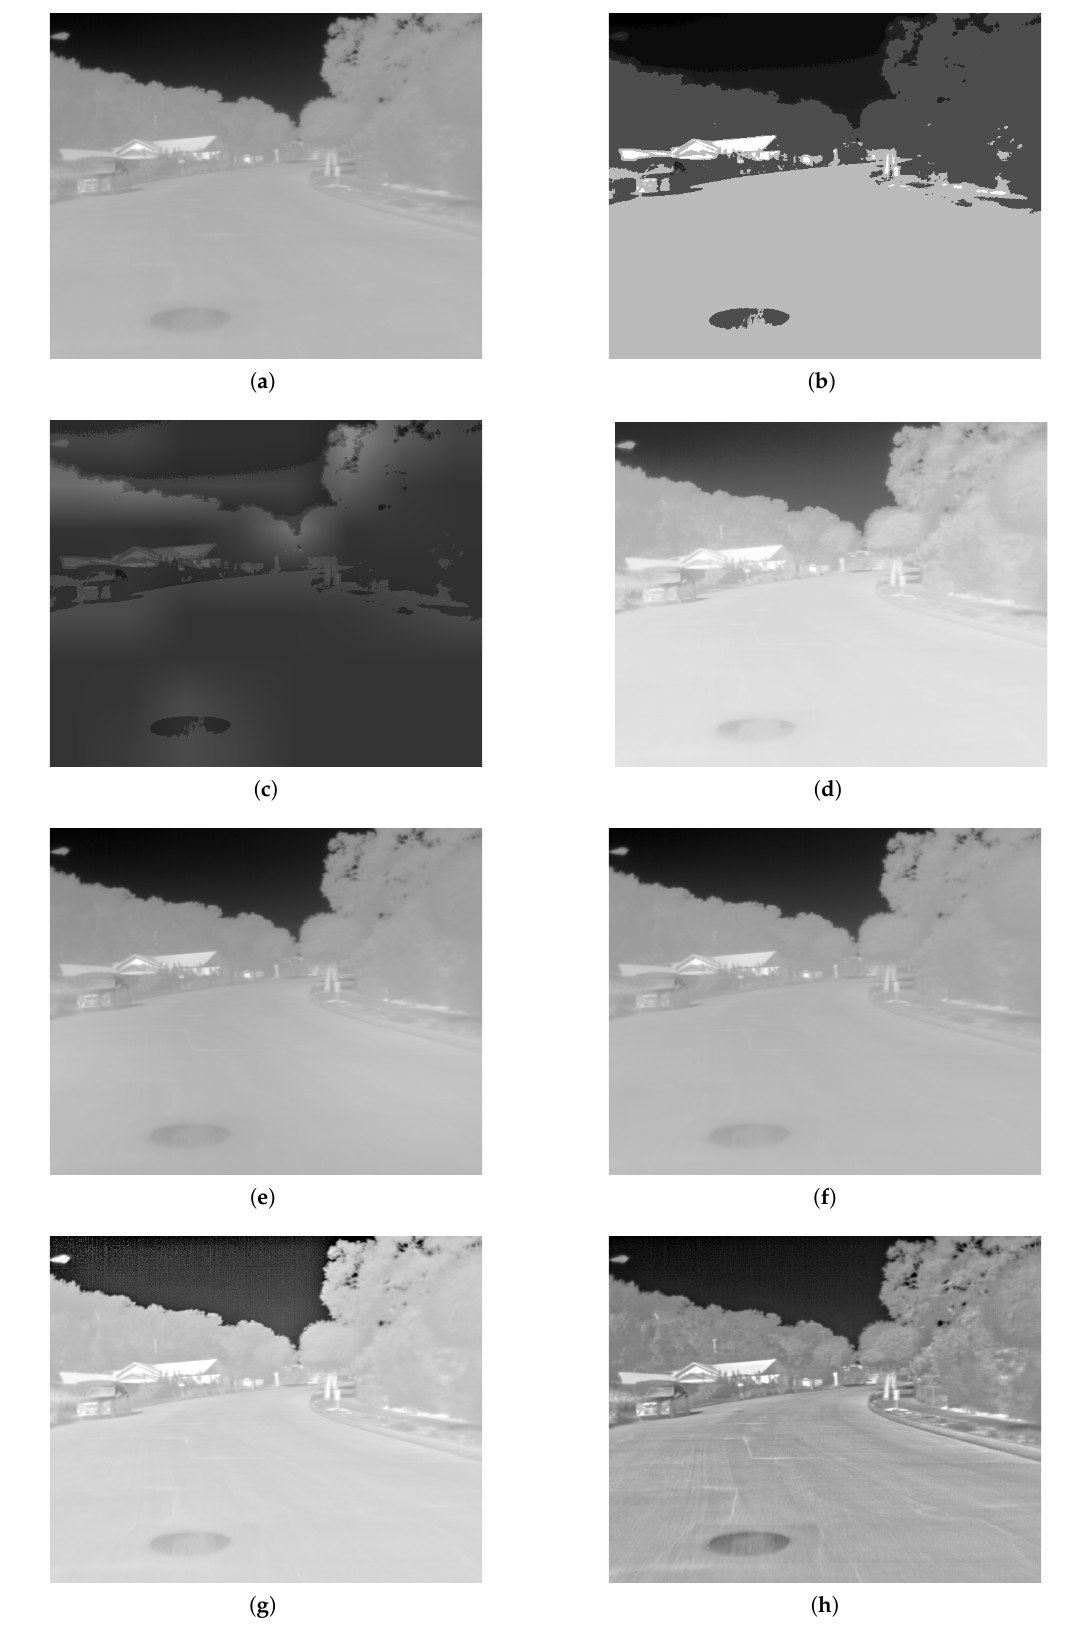
Figure 7. Comparison Results 4 (Foggy Image). ( a ) Linear Mapping. ( b ) HE. ( c ) CLAHE. ( d ) AHPBC. ( e ) MSR. ( f ) Reinhard. ( g ) LEP. ( h ) Proposed